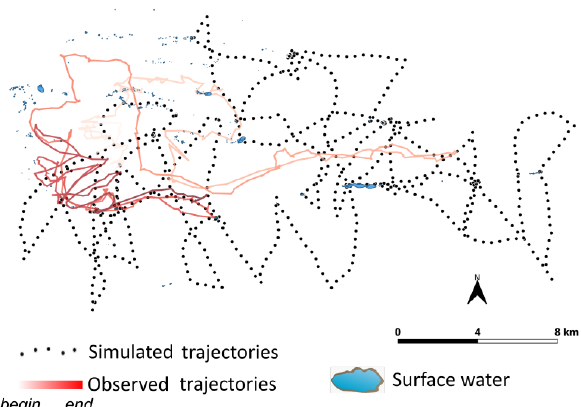
Figure 5. Observed and simulated herd’ centroids trajectories comparison for a period of one month. The observed trajectory is symbolized by the graduated red line (from light red that symbolizes the beginning of the period to dark red that symbolizes the ending of the period). The black dot points represents the simulated herd’ centroids